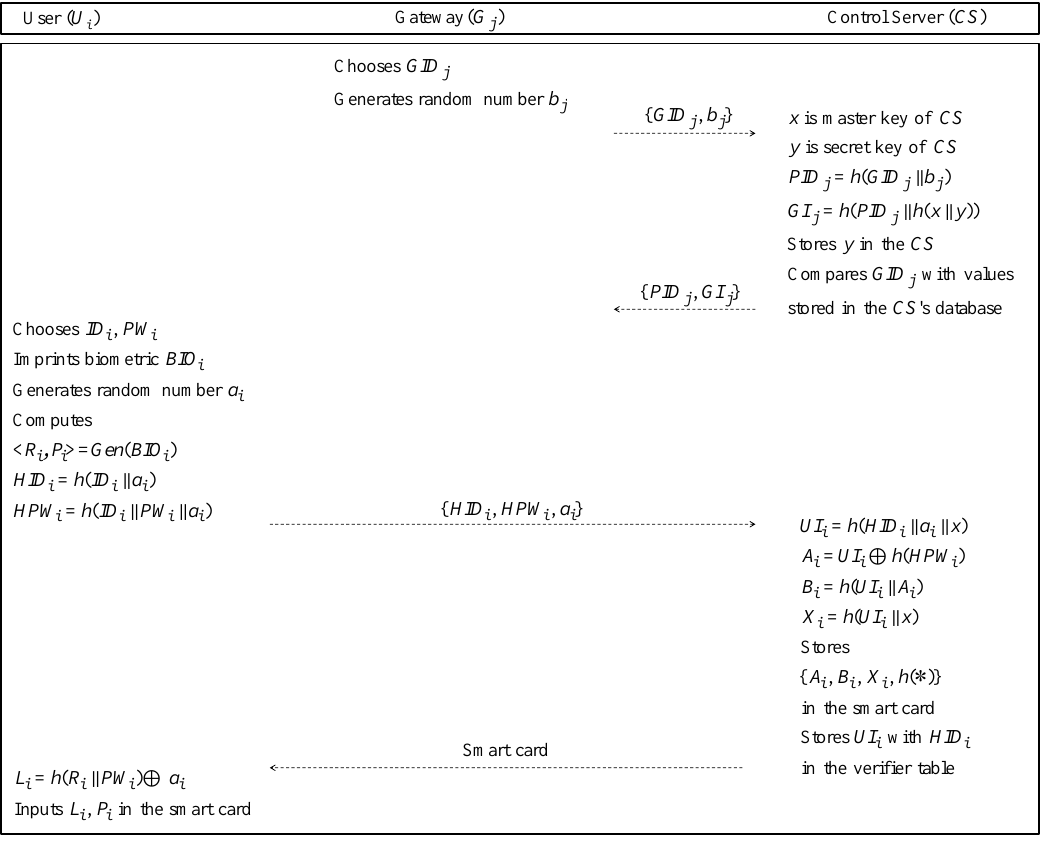
Figure 5. Registration phase of our proposed